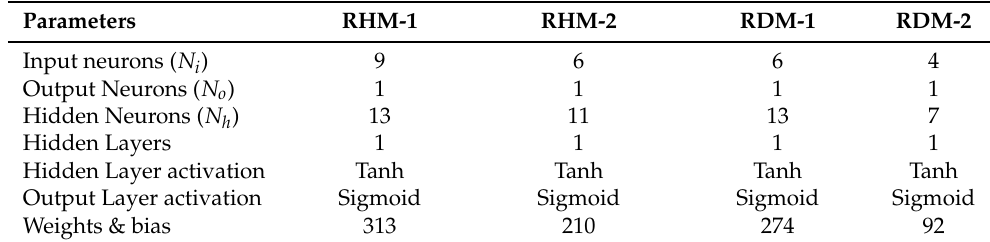
Table 2. Summary of the RNN